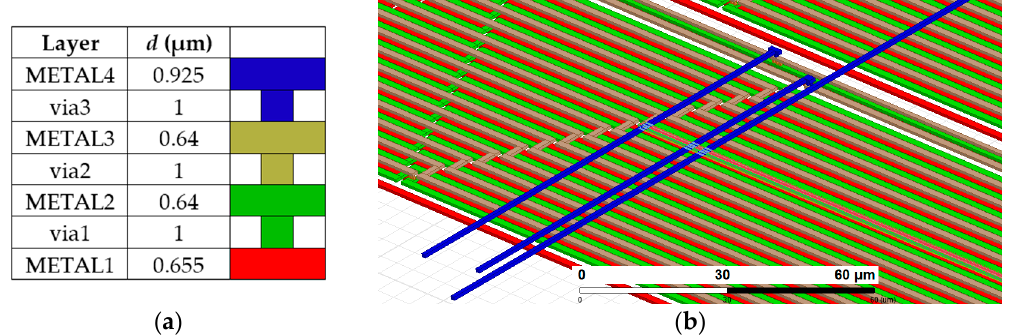
Figure 3. ( a ) The 3D model of a single microtransformer introduced into the parasitic extraction software; ( b ) The winding structure used in the microtransformers. Layer thicknesses and color coding are given in Figure 4a; ( c ) The model circuit of a single microtransformer. The components’ values are given in Table 1.